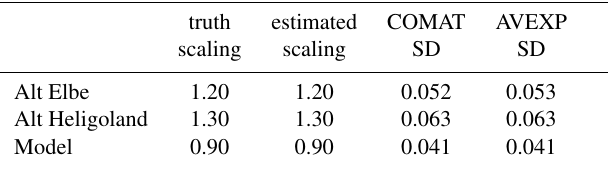
Table 4. Parameters used for the Monte Carlo simulations to validate the approach described in Sect. 2.2 for the quantification of errors in the calibration factor estimates. The MULTCOL technique is applied to a 1-D configuration with five data sources, of which three (two altimeter (Alt) observations and one model estimate) are affected by calibration errors. The first column gives the assumed truth scaling parameters and the second column gives the respective estimates. The last two columns represent the uncertainty estimates for the derived scaling parameters in terms of standard deviation (SD) based on two different procedures. See text for